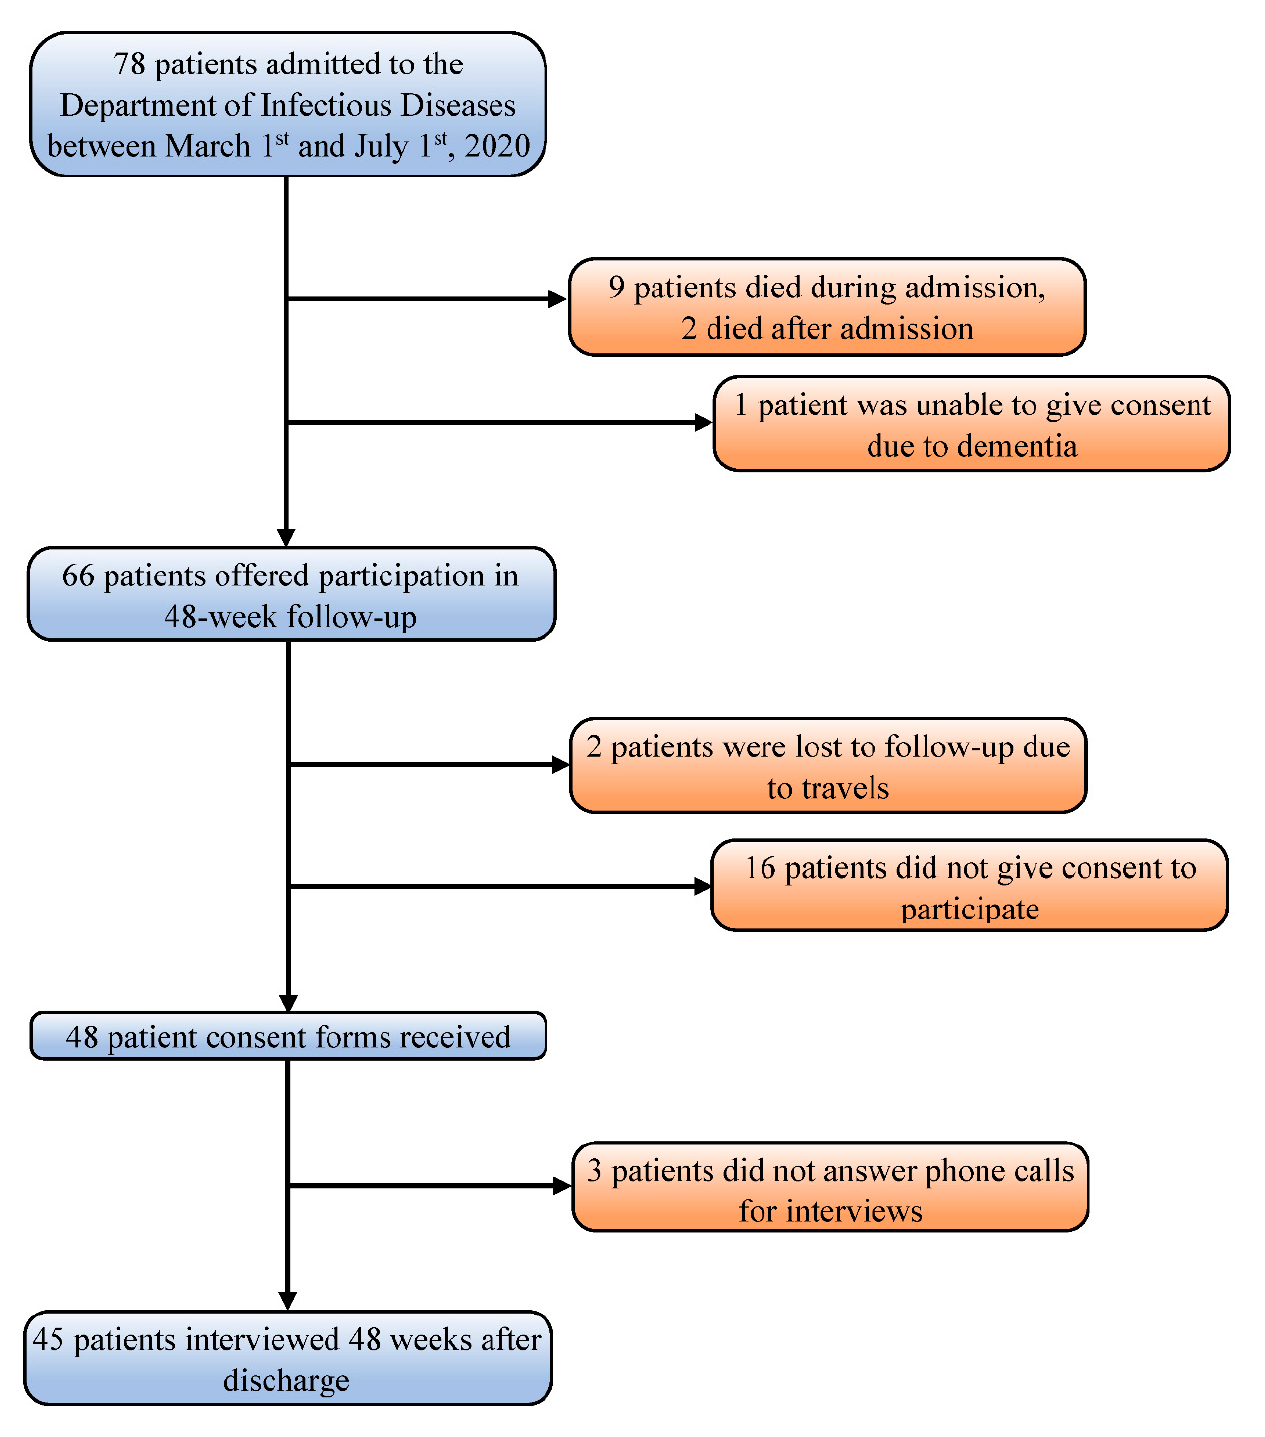
Figure A2. Flowchart of the cohort. Table A1. Characteristics of the enrolled patients.